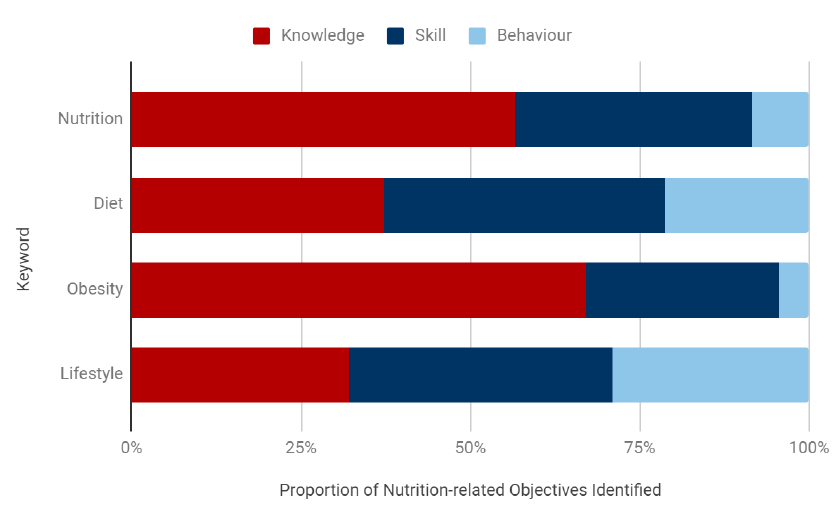
Figure 5. Proportion of knowledge-, skill-, and behaviour-based outcomes per keyword across specialties.